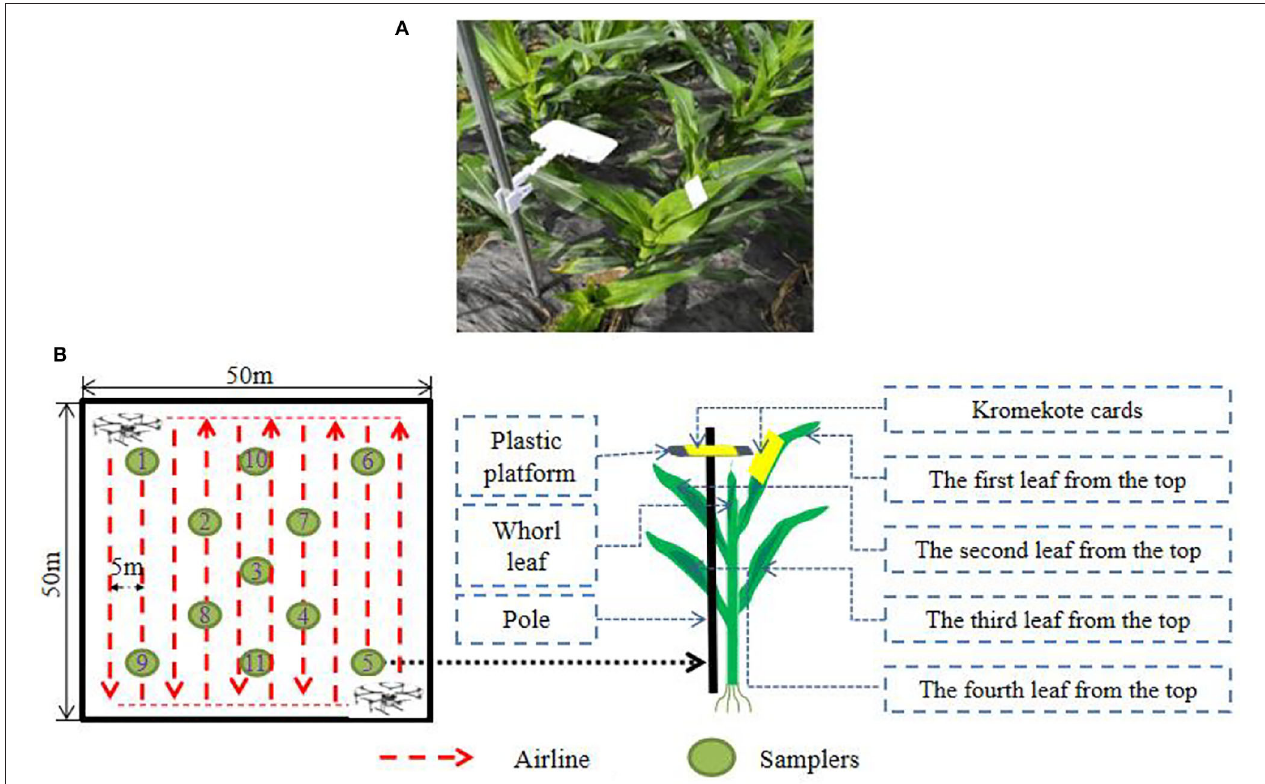
FIGURE 2 | (A) The actual arrangement in the field. (B) Sampling point